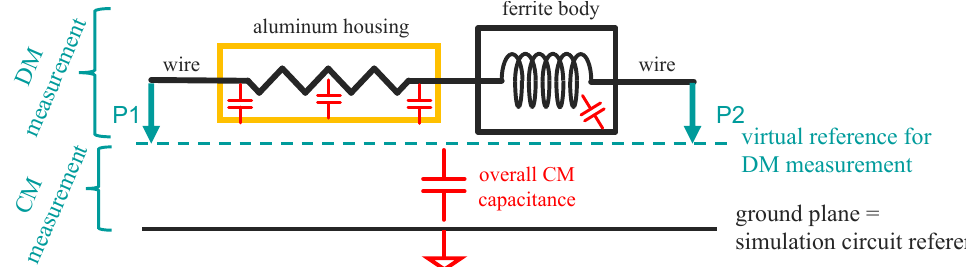
Figure 3. Measurement concept to obtain DM and CM load impedance for circuit simulations, reflecting the setup of interest. The CM measurement captures the overall coupling capacitance towards the common ground